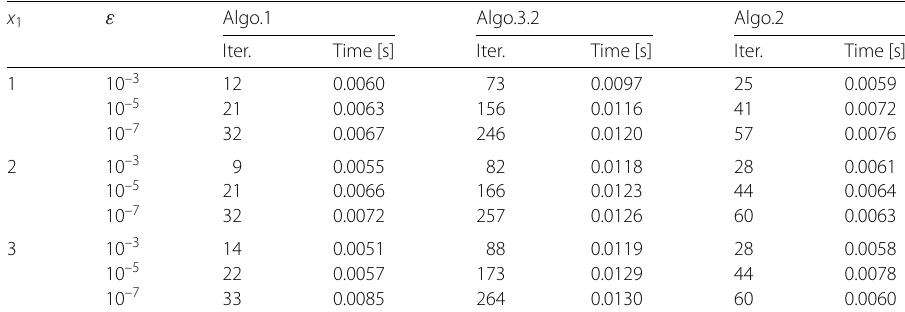
for Example n +1